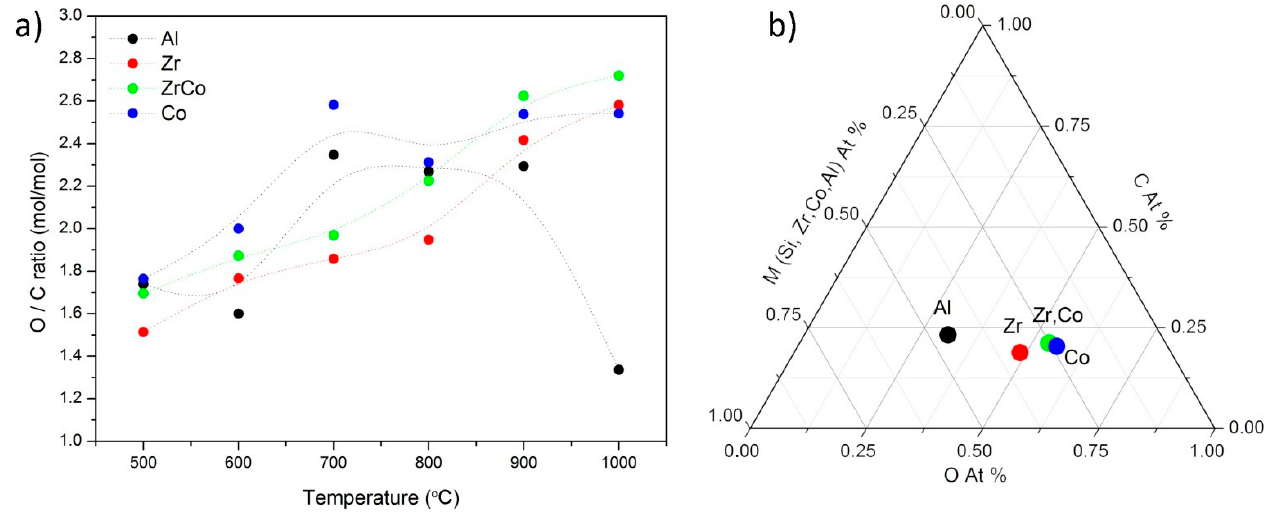
Figure 1. ( a ) O/C ratio of the samples and its evolution with pyrolysis temperature (dotted lines are drawn to guide eye) and ( b ) ternary diagram of the samples pyrolyzed at 1000 °C.